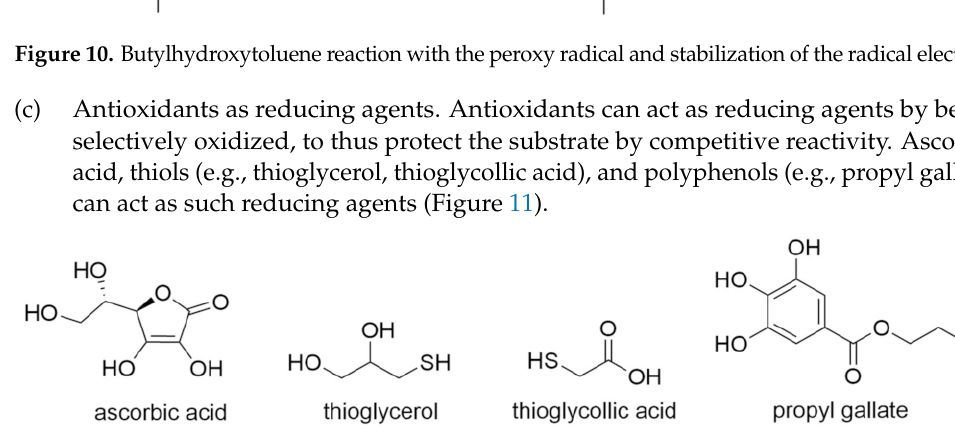
Figure 11. Reducing